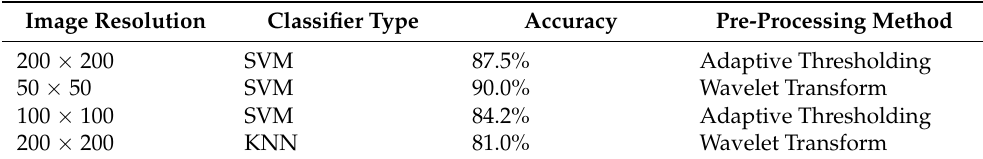
Table 1. Classification performance impact at different resolutions and pre-processing